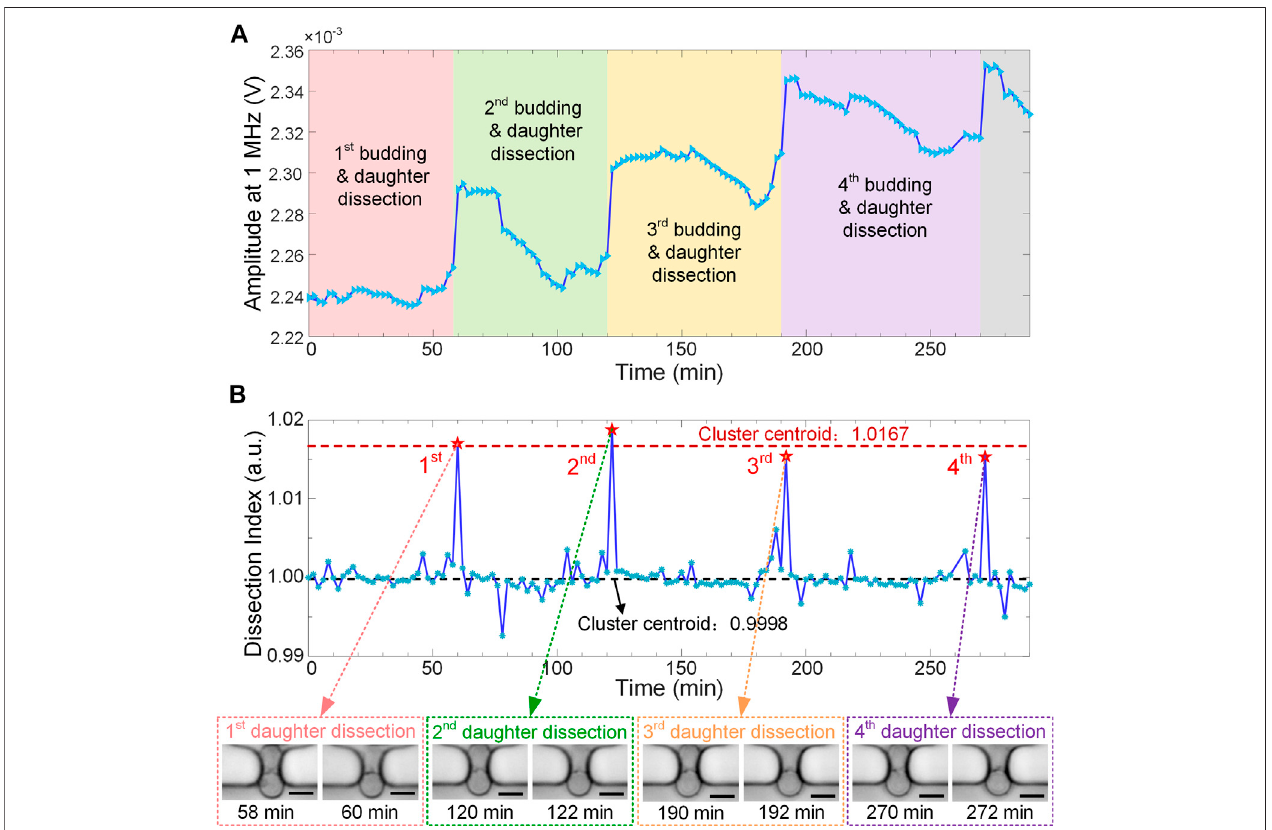
FIGURE4 | Real-time EIS monitoringof budding yeast growth and division with4 daughter-dissection events in sequence. (A) Rawamplitude curveof EIS signals at1 MHzalongtherecordingtimeperiod.Samplingintervalis2 min (B) “ DissectionIndex ” curvecombinedwithK-meansclusteranalysisclearlyshowing4sharpspikes corresponding to daughter-dissection events of the recorded mother cell. Insets show micrographs of the yeast mother cell right before and after daughter removal. Scale bar is 4 μ m.